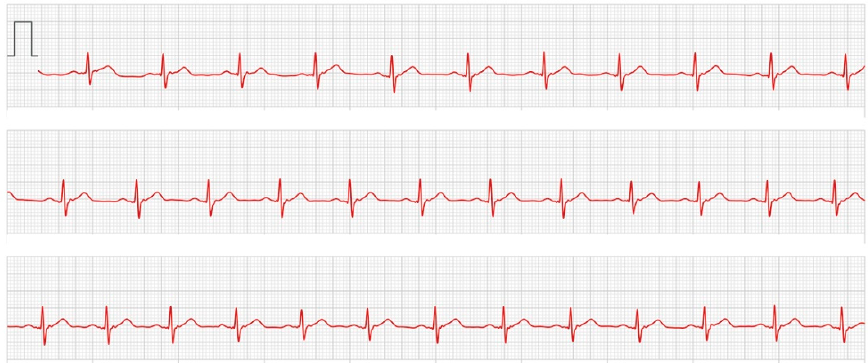
Figure 4. Electrocardiogram collected at 30 min after cessation of the arrhythmia. 25 mm/s, 10 mm/mV, iOS v.15.4.1, Apple Watch 4.2, algorithm v.1.